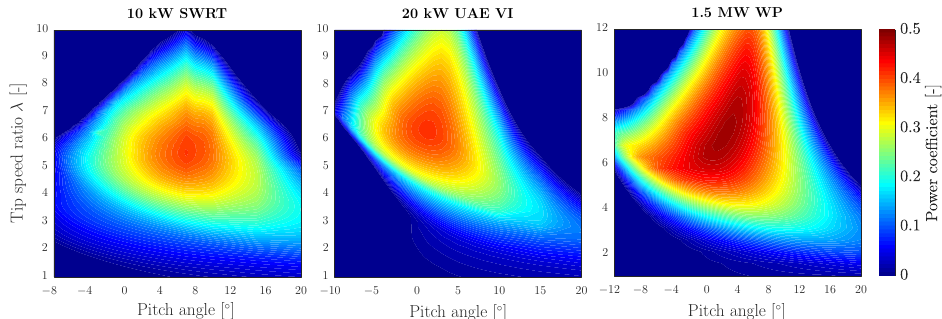
Figure 2. Power coefficient C P of the wind turbines as a function of pitch angle θ and tip speed ratio λ .